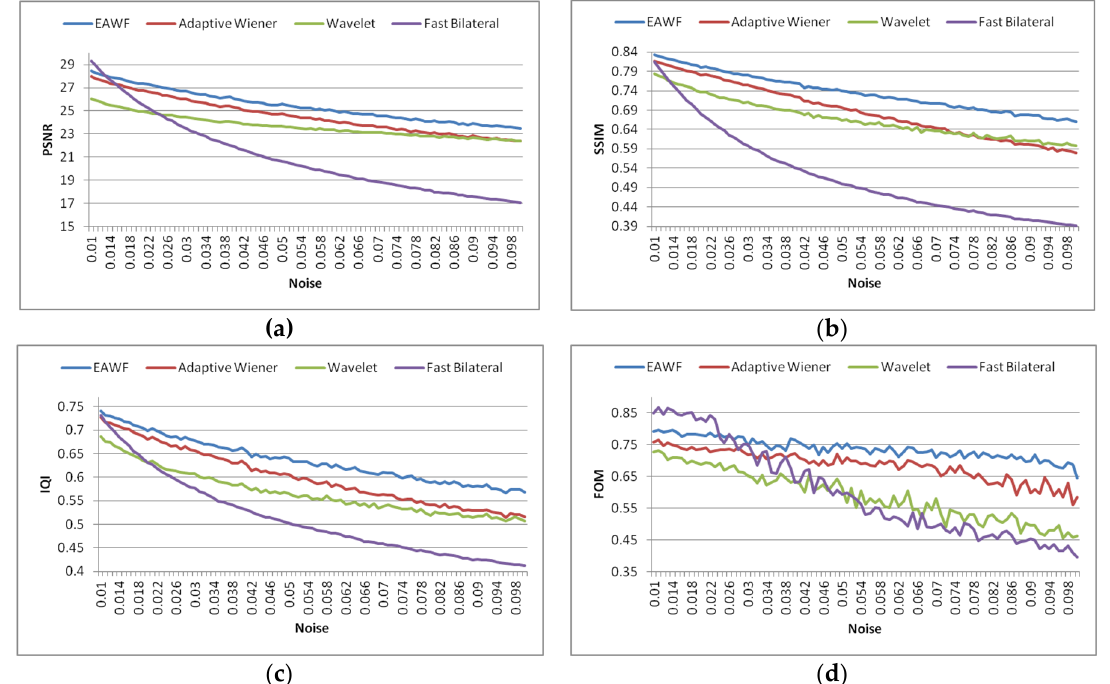
Figure 3. Comparisons of the HAWF the EAWF, the homogeneous fast bilateral filter and the homogeneous wavelet filter with the PSNR, SSIM, IQI, and Pratt’s FOM quantitative measurements: ( a ) the EAWF and existing methods are compared by PSNR, ( b ) the EAWF and existing methods are compared by SSIM, ( c ) the EAWF and existing methods are compared by IQI, ( d ) the EAWF and existing methods are compared by Pratt’s FOM.